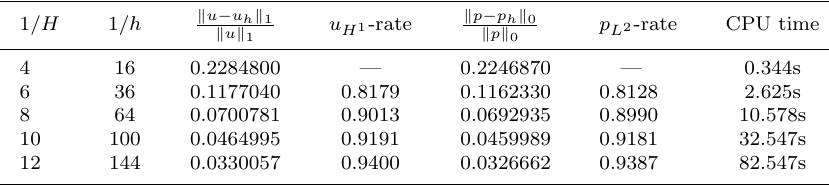
Table 5. Relative error and convergence rate of the two-grid method for the velocity and flux with τ 2 = h and ν = 0 . 01. 1 /H 1